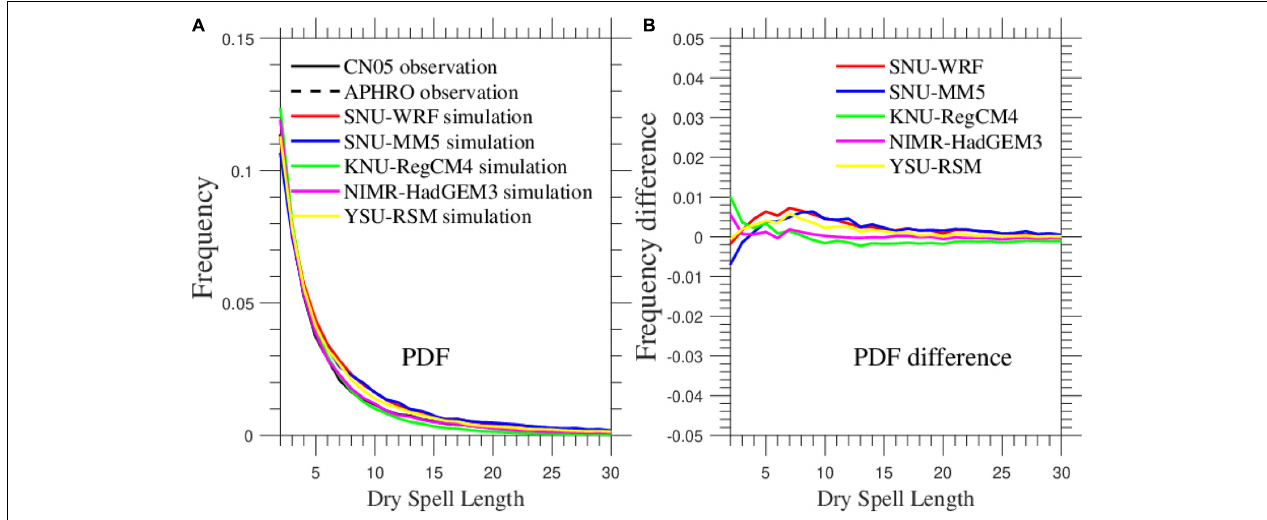
FIGURE 5 | (A) Probability distribution functions of dry spell length (days), for rainfall in two observational datasets and five RCM simulations. (B) PDF differences of five RCMs against CN05 observational data. The different line colors represent two observations (CN05 and APHRO) and five RCM simulations (SNU-WRF, SNU-MM5, YSU-RSM, KNU-RegCM4, and NIMR-HadGEM3),